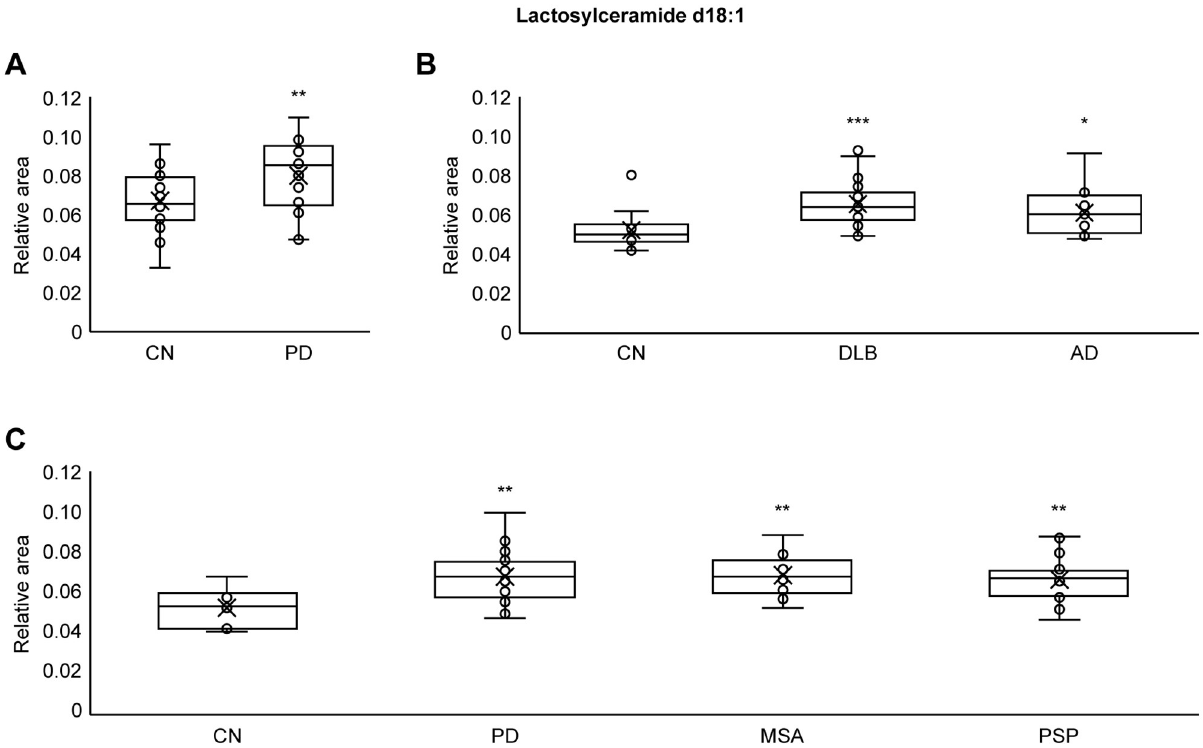
Fig 3. Plasma LacCer levels in neurodegenerative diseases. (A) Plasma LacCer d18:1 levels were significantly higher in the IPD group of cohort A (p < 0.01) than in the CN group. (B) Plasma LacCer d18:1 levels were significantly higher in the DLB group (p < 0.001) and AD group (p < 0.05) than in the CN group. (C) Plasma LacCer d18:1 levels were significantly higher in the IPD group of cohort C (p < 0.01), MSA group (p < 0.01) and PSP group (p < 0.01) than in the CN group. Statistical significance was examined using one-tailed Welch’s t tests (P < 0.05). Circles indicate the data points between the lower and upper whiskers, and x indicates the average marker in a box/whisker diagram.